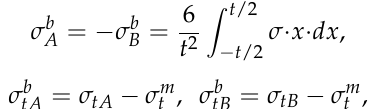
Figure 3. Stress linearization through the thickness of the cladding.